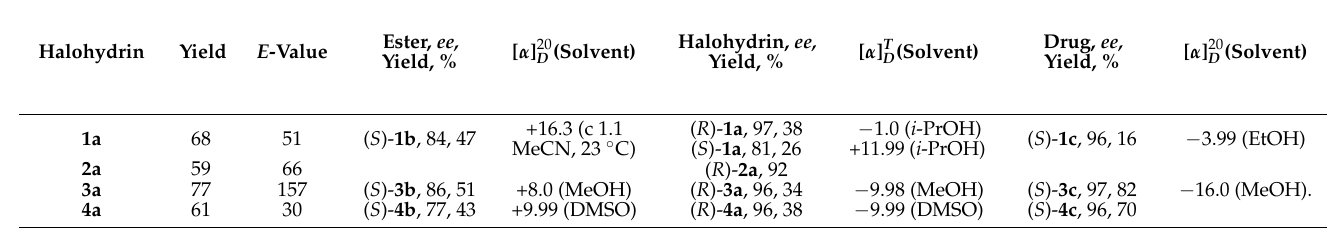
Table 3. E -values, ee -values and yields of racemic building blocks 1 - 4 and of R -alcohols ( R )- 1a - 4a and the drugs ( S )- 1c - 4c from the reactions of 1 - 4 with vinyl butanoate as acyl donor to produce the butanoates ( S )- 1b-4b leaving the R -enantiomers unreacted. Different solvents were used, and the kinetic resolutions were catalyzed by lipase B from Candida antarctica . Optical rotations [ α ] T were determined at 20–23 ◦ C in different solvents with c = 1; for additional parameters, see the D experimental